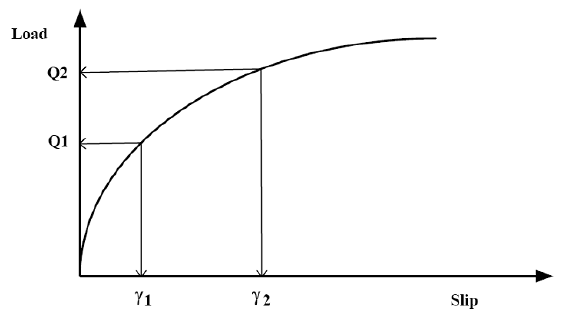
Figure 2. Typical load-slip relationship from the standard test.